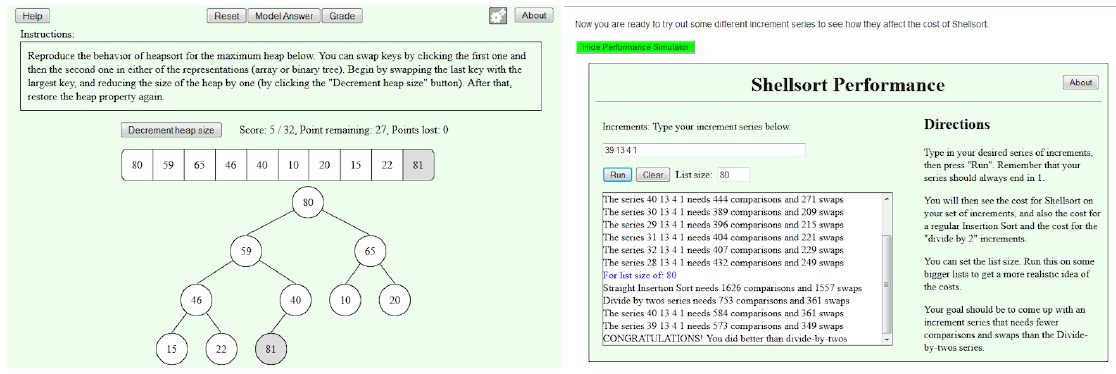
Figure 1. OpenDSA visualizations and